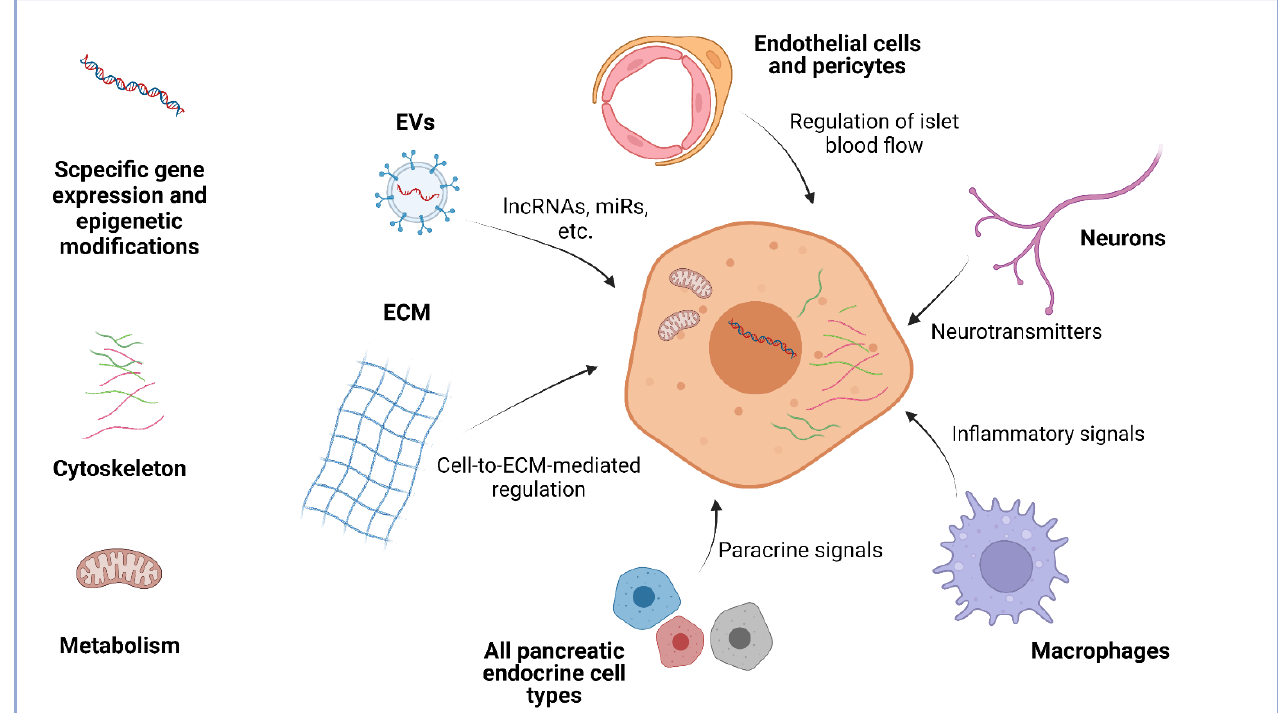
Figure 2. The microenvironment of beta cells includes many components such as pancreatic islet endocrine cells, endothelial cells, pericytes, neurons, macrophages, the extracellular matrix (ECM), and EVs (extracellular vesicles). All of them send different signals to beta cells, affecting their viability, proliferation, gene expression, and functions such as GSIS. These effects can be both negative and positive. Intracellular regulatory signals include genetic and epigenetic cues, cytoskeleton, and metabolic states. By intensifying some regulators and blocking others, it is possible to promote maturation, GSIS, and graft survival, which are all crucial for stem cell therapy of diabetes. LncRNAs-long non-coding RNAs; miRs-microRNAs. Created with BioRender.com.